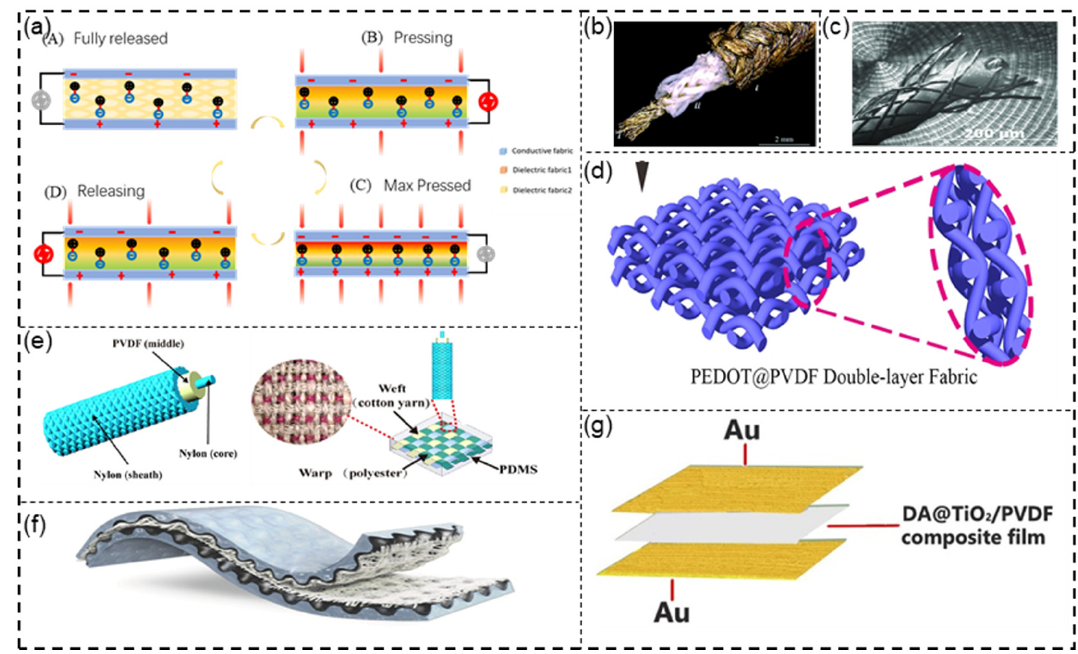
Figure 5. ( a ) Working mechanisms of textile-based PENGs. ( b ) One-dimensional single fiber-based PENG Reprinted with permission from Ref. [96]. Copyright 2019 Royal Society of Chemistry. ( c ) One-dimensional single fiber-based PENG Re-